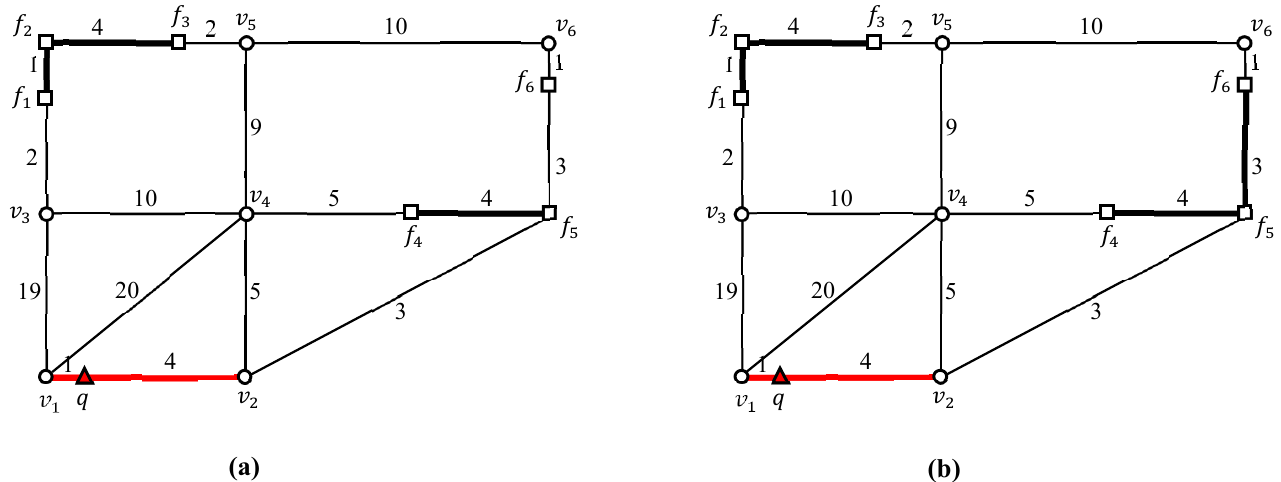
Figure 5. Clustering method for grouping facilities into facility clusters: ( a ) grouping facilities into facility segments; ( b ) grouping facility segments into facility clusters.